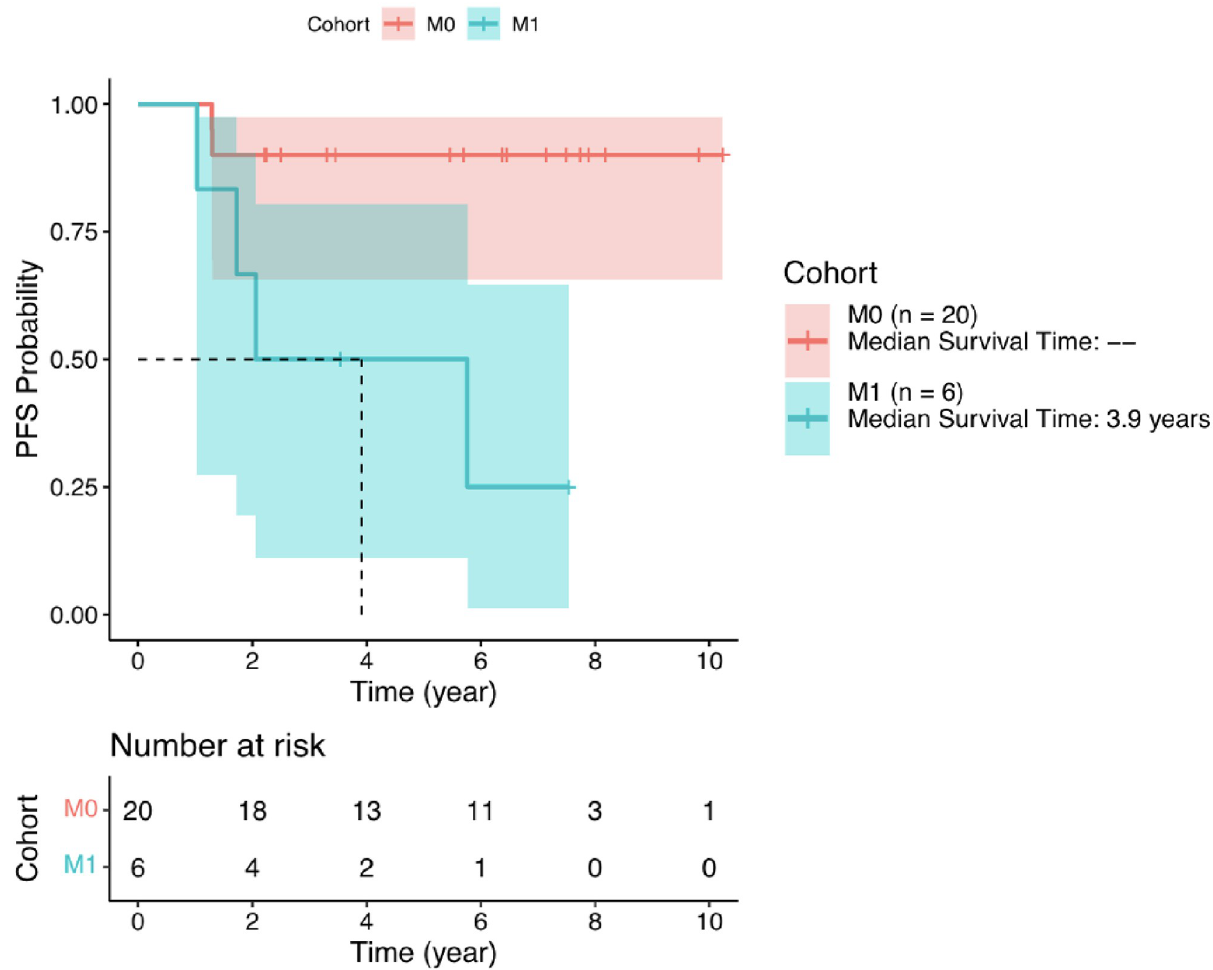
Fig 3. Kaplan-Meier progression free survival curve for M0 cohort and M1